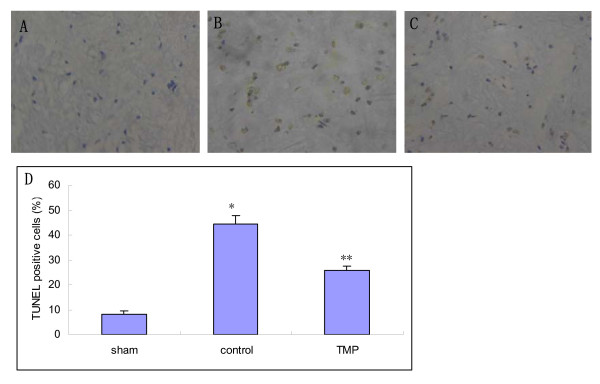
Effects of TMP on cell apoptosis in the spinal cord at the 48th hour reperfusion. Representative images of TUNEL staining (magnification × 200) in sham group (A), Control group (B) and TMP groups (C). Quantitative analysis of apoptosis rate (D). Cell apoptosis was determined using TUNEL staining as described under "Methods". Cell apoptosis rate is expressed as the mean ± S.D. from three experiments. *P < 0.01, vs sham group; **P < 0.01, vs control group.